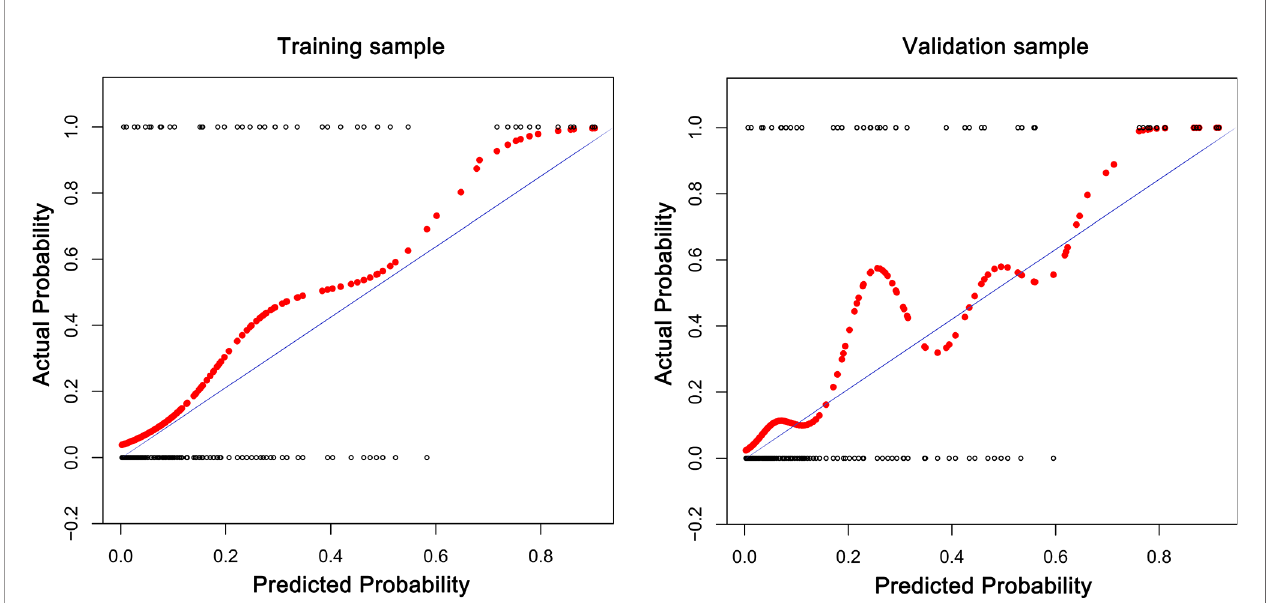
FIGURE 4 | The calibration curves for assessing the consistency between the predicted and the actual risk of postoperative VTE. Favorable consistencies between the predicted and the actual risk evaluation are